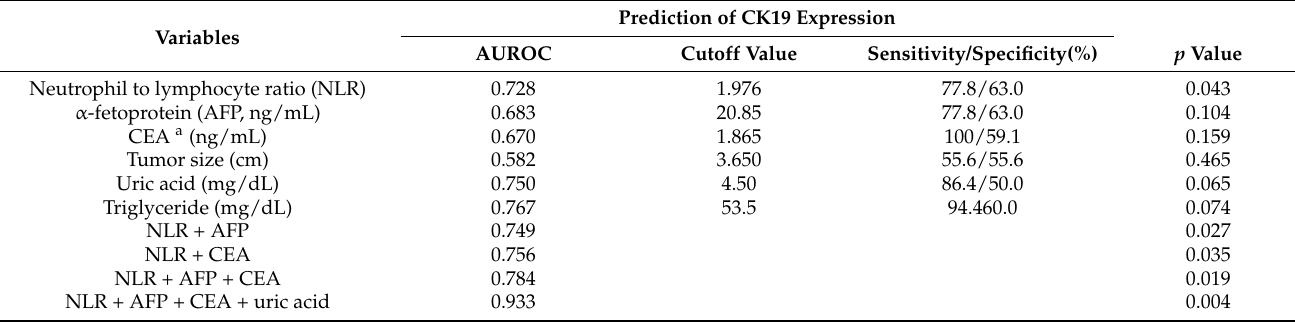
Table 3. Area under the ROC curve (AUROC) in predicting CK19 expression in hepatocellular carcinoma (n = 36). Prediction of CK19 Expression Variables AUROC Cutoff